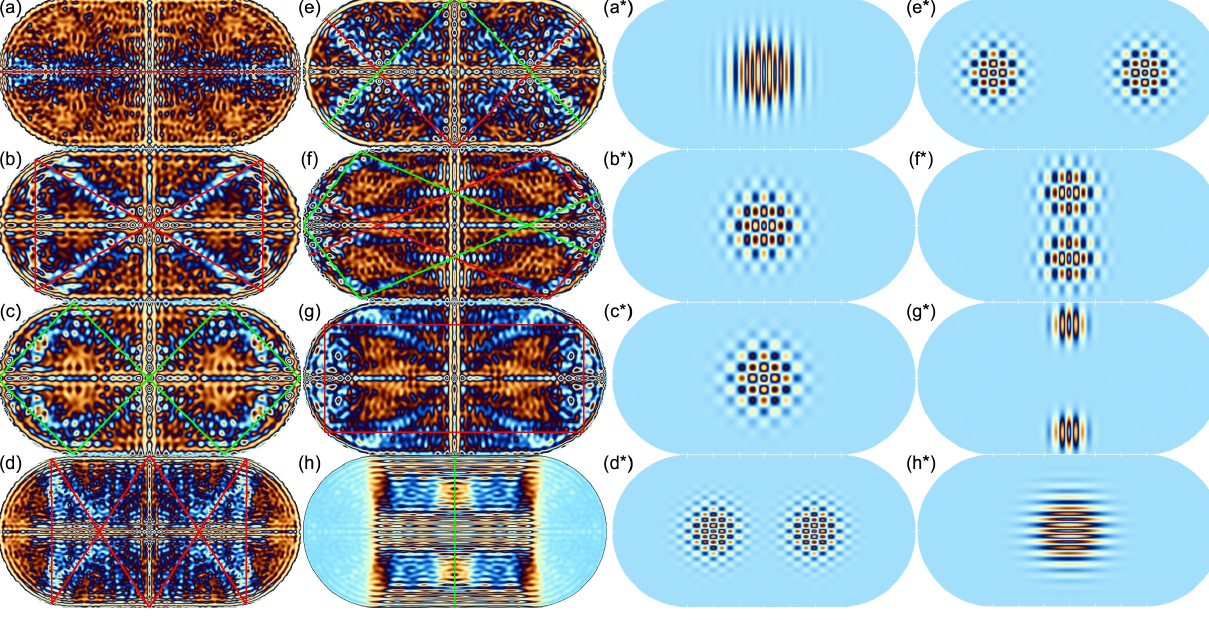
Figure 3: Scars of the wave stadium function illustrated corresponding to 3,300 iterations of 6 distinct repelling periodic orbits in the classical system. Each of the wave functions in panels (a-h) is iterated from the corresponding generating function in panels (a*-h*), whose wavelength and direction is chosen to correspond to a fraction of the orbit length. The scars are formed by superimposing the squared wave functions at each complete revolution of the phase angle (corresponding to 11 steps of iteration because of the choice of stadium size and initial generator). The rectangular orbit scar in panel (g) also shows resonance with the bow tie in panel (b). Its orbit-length-dividing period of 1.2 relative to panel (a) is close to the bow tie’s 1.29 and it closely shares the vertical section of its orbit with panel (b). (h) A vertical wave generator corresponding to the neutral vertical orbit, produces an ordered wave function. (a*-h*) The generating functions for the scars in panels (a-h) consisted of radial Gaussian wave packets of plane cosine waves aligned along the classical repelling orbits shown with wave periods a fixed fraction of the orbit